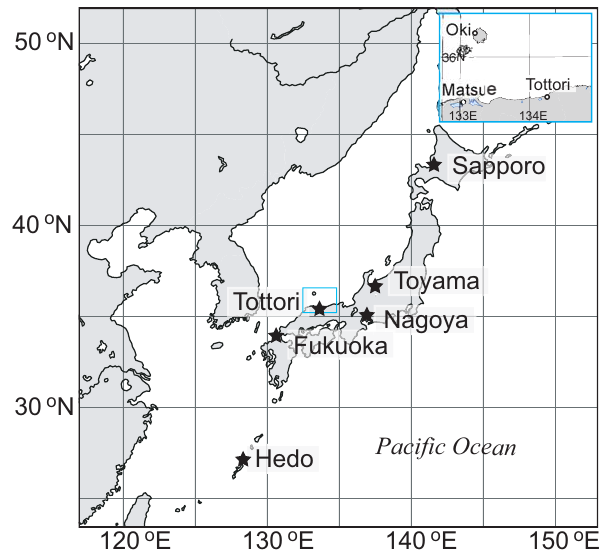
Fig. 1. Map showing observation sites. The blue rectangle in the upper right corner is an enlargement of the map near Tottori, show- ing positions of Oki Island (PM 10 and PM 2 . 5 measurements by EANET) and Matsue (Lidar observation by